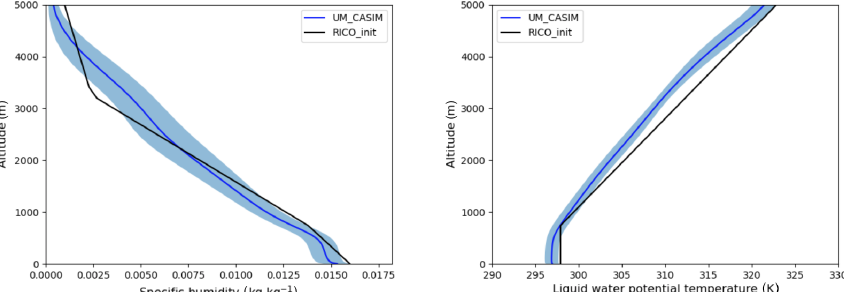
Figure 3. Domain-averaged vertical profiles of liquid water potential temperature and specific humidity for the baseline case, compared to the RICO initial setup, with the standard deviation of the baseline